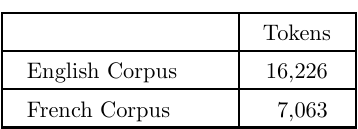
Size of the two corpora English